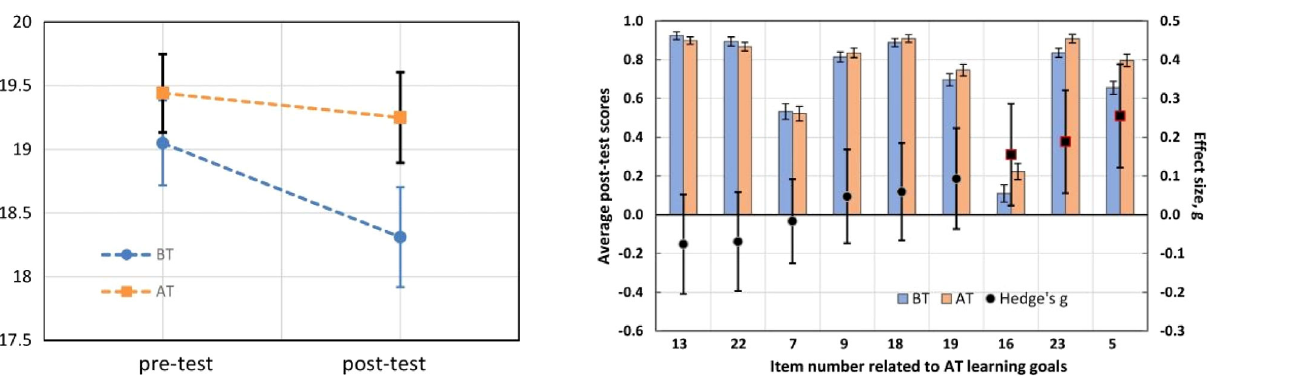
FIG. 6. Men ’ s average post-test scores in the BT (blue) and AT (orange) courses on E-CLASS items (bar graph) that are related to the AT course learning goals. Effect sizes, Hedge ’ s g and the corresponding 95% confidence intervals, are plotted as symbols for each of the items. Items with significant differences between BTand AT post-test scores for men are denoted by square symbol.